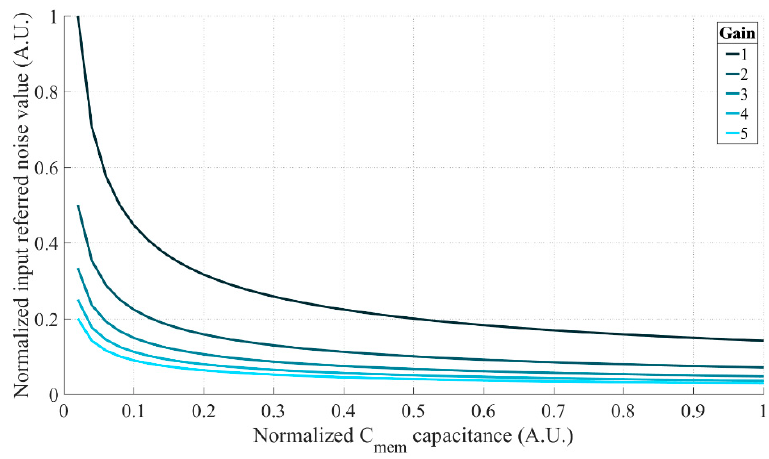
Figure 3. The input referred memory sampling noise against the capacitance value w.r.t. the amplification gains varying from 1 to 5.